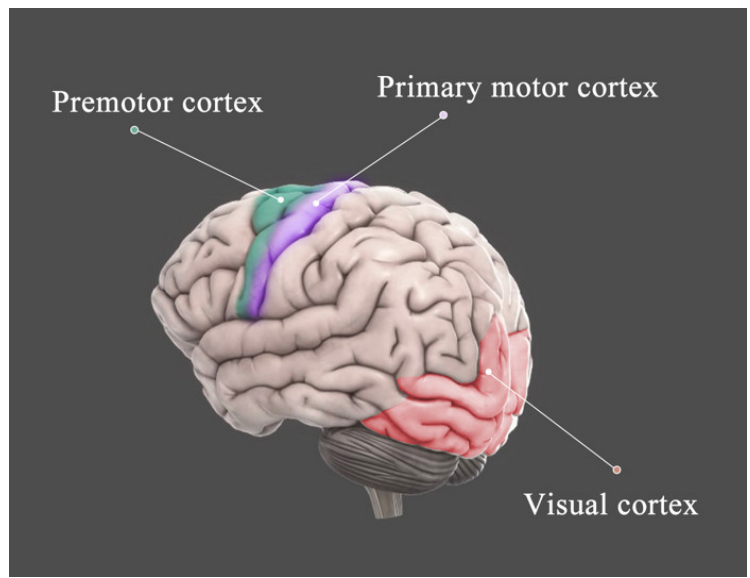
Figure 6. The schematic figure of the visual cortex and the motor cortex. Hypoxia/reoxygenation increased ALFF in the occipital visual cortex, precentral gyrus, and supplementary motor cortex, which may be associated with an increase in vasculature. Moreover, previous studies have found that high altitude exposure increased the cortical thickness in the visual cortex and motor cortex which may also have been due to increased vascular density [19,38]. Studies in animals have been consistent with our results, showing that the increase in blood vessels caused by hypoxia did not return to the baseline level after reoxygenation for a while. Previous studies have found that cerebral microvessels were significantly increased after 1 and 3 weeks of hypoxia, and remained elevated after 3 weeks of normoxia in rats [35]; after 8 weeks of hypoxia and reoxygenation for 8 weeks, the blood vessel area was still increased in rats; cyclooxygenase-2 and angiopoietin-2 were both elevated during hypoxia for 21 days as well as subsequent re-oxygenation for 21 days in mice [36]. In a natural environment, the visual cortex continuously receives external information which is the most active, and the motor cortex continuously outputs motion signals. The visual cortex and the motor cortex may require greater oxygen consumption than other cortices, and therefore, are more sensitive to hypoxia. Increased neuronal activity after high altitude exposure is consistent with previous studies. Zhao et al. recorded EEG activity in resting state at four time points: before ascending to high altitude, during 7 days and 30 days at 3800 m altitude, and 7 days after return to sea level. They found a persistent increased beta power in the parietal cortex and occipital cortex during the first 7 days at high altitude and after 7 days return to sea level [18]. Beta activity is indicative of background excitation that involves a frequency potentiating mechanism at the synaptic